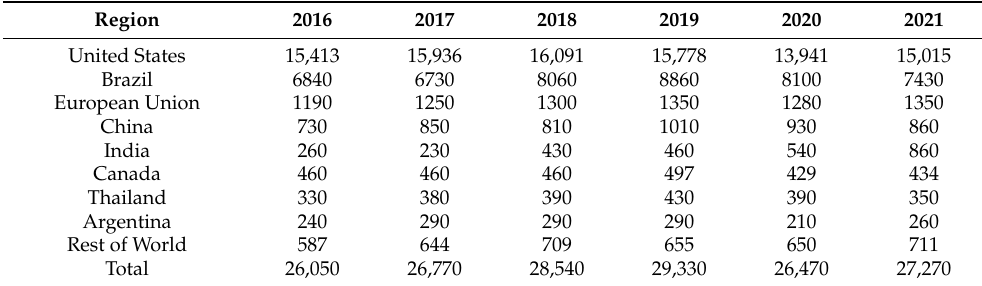
Table 3. Global annual fuel ethanol production by country/region from 2016 to 2021 in millions of gallons [72].